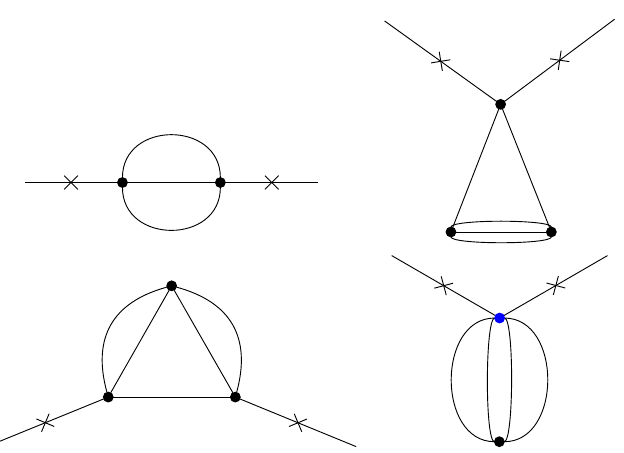
. The φ 6 vertex is ShG